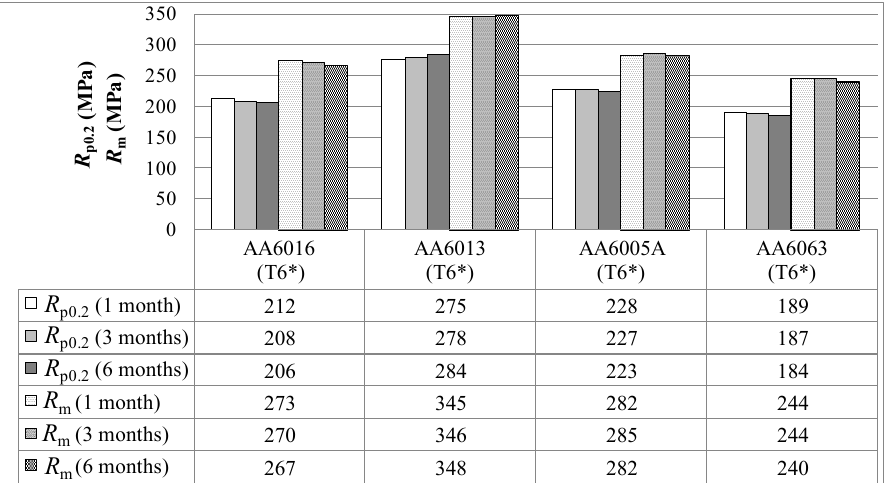
Figure 6. Yield tensile strength R measured one, three and six months after sheet production